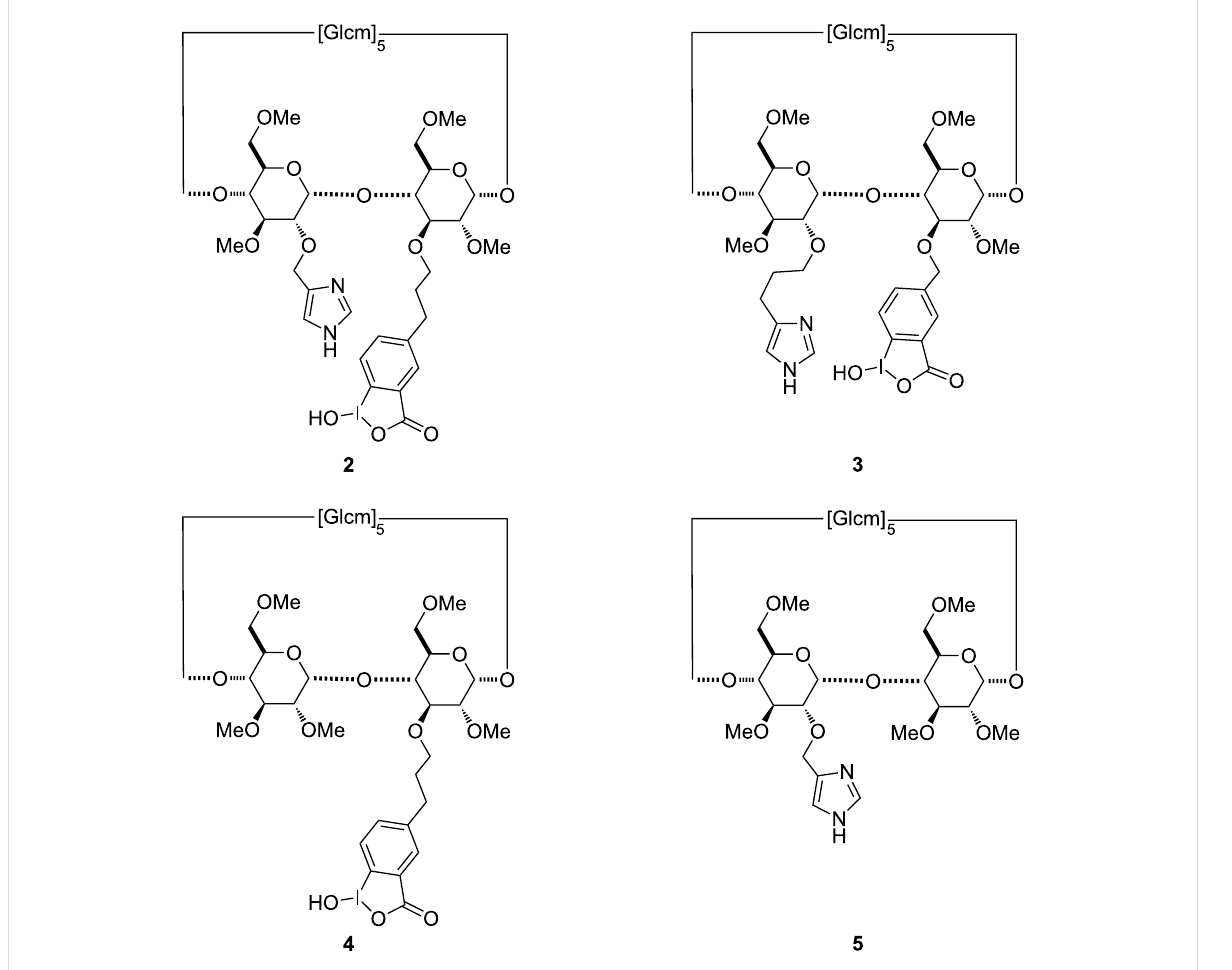
Figure 3: Structures of β -cyclodextrin derivatives 2 – 5 .